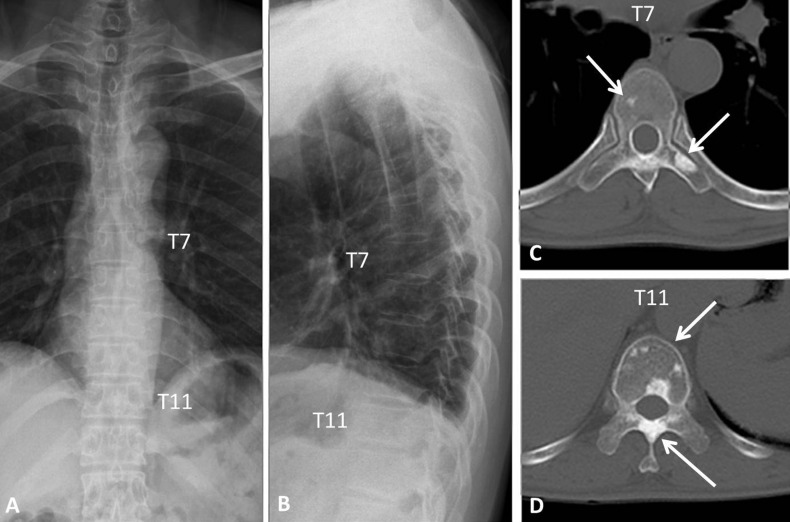
Thoracic spine of a 54-year-old male with POEMS syndrome.Antero-posterior (A) and lateral thoracic (B) spine X-rays were interpreted as normal. Sclerotic lesions of the vertebral body and appendix (C, D) were clearly observed by CT (arrows).